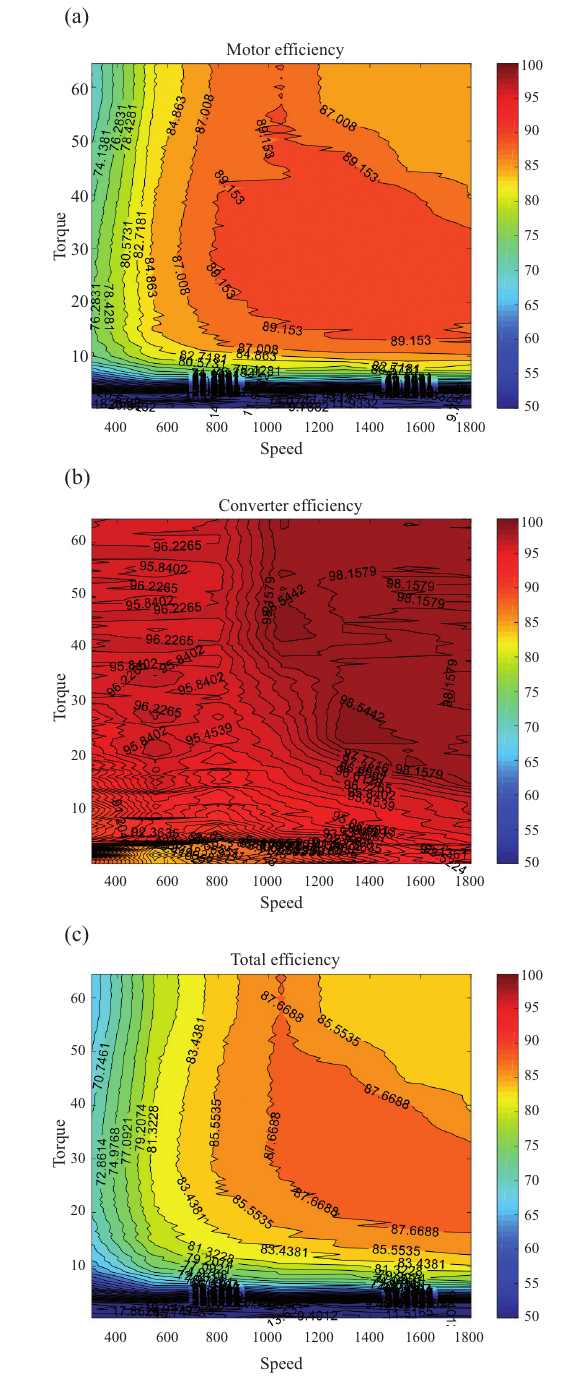
Fig. 3. Efficiency maps of the studied SynRM (a), feeding SynRM frequency converter (b), and the whole SynRM motor­ drive system